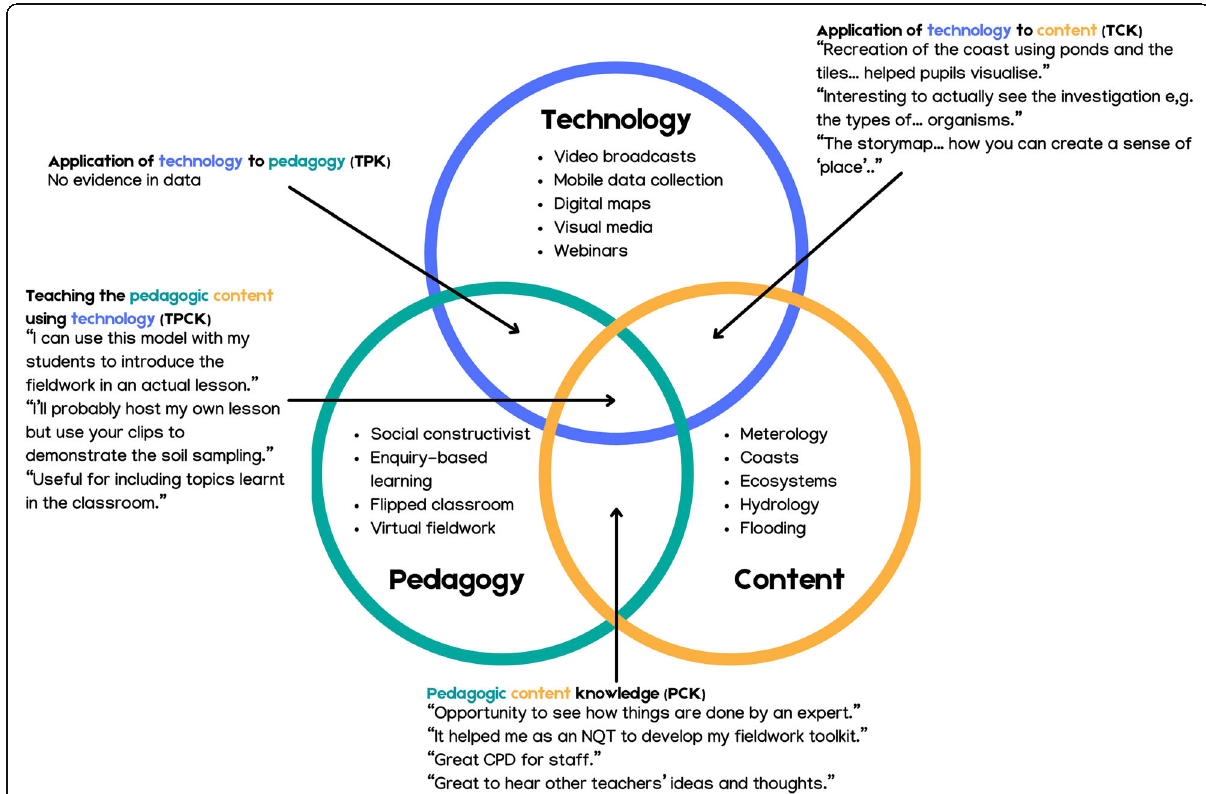
Fig. 5 Emerging model for the affordances provided by this technology enhanced approach, based on Koehler and Mishra ’ s (2005) framework (quotations are derived from teacher feedback